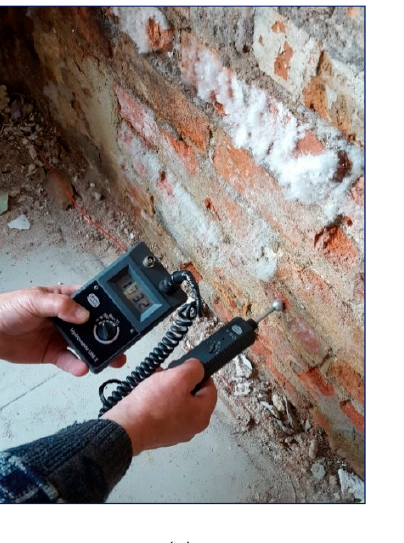
( b ) Figure 11. Moisture tests of an internal brick pillar: ( a ) view of the pillar with the EIT electrodes applied; ( b ) distribution of measure- ment points for comparative dielectric, microwave and gravimetric methods